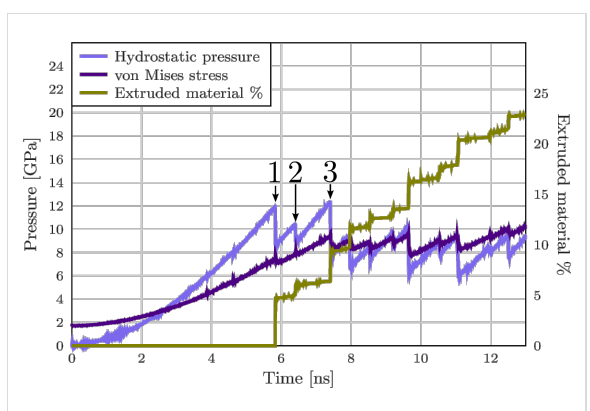
Figure 3: Extrusion from a 15 Å orifice. Hydrostatic pressure, von Mises stress and the amount of extruded material as a function of the simulation time. The nonzero initial value of the von Mises stress is due to the initial shear stresses at the faceted surface of the nano- particle.